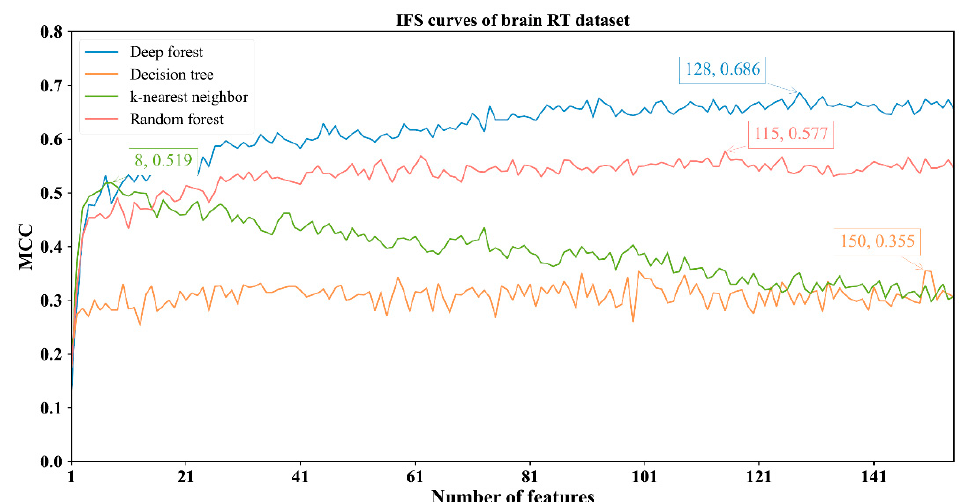
Figure 3. IFS curves with different classifiers on the different numbers of methylation features for brain RT methylation dataset. DF attains the highest MCC value of 0.686 when the top 128 features are utilized.